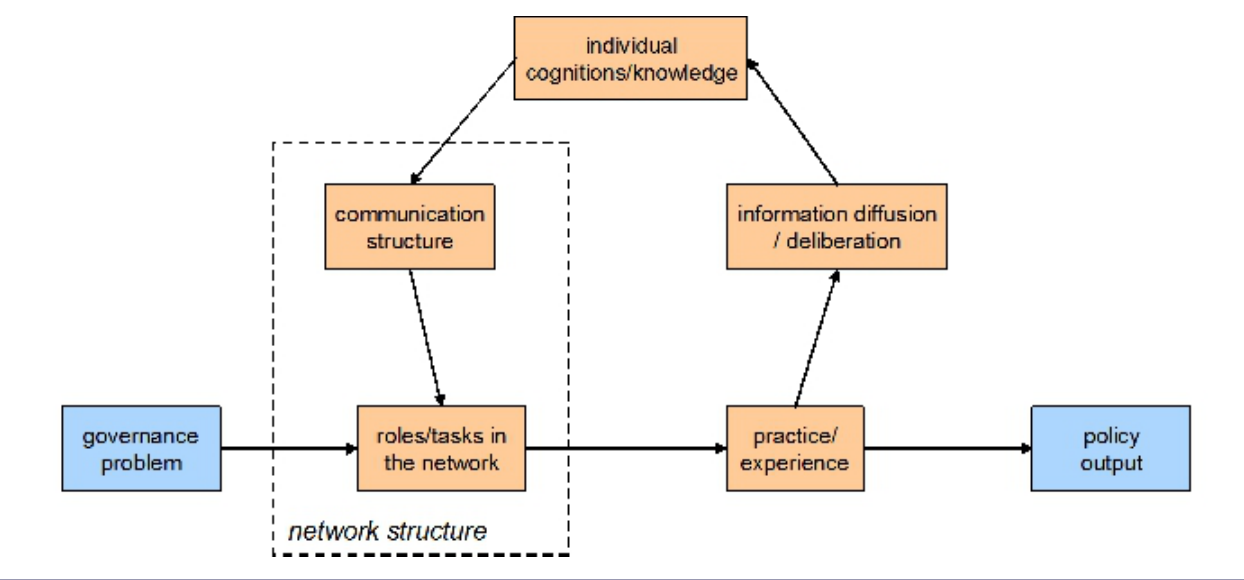
Fig. 1. Conceptual model of the role of networks and collective learning for sustainability transitions. Adapted from Newig and Günther